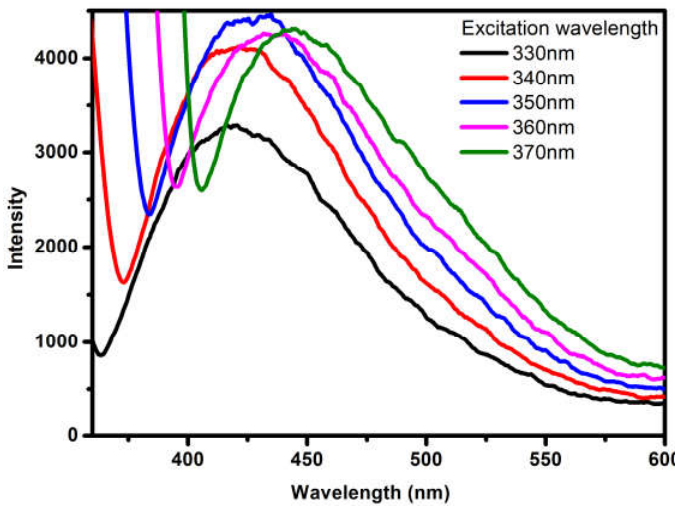
Figure 9. Emission spectra of PANI-Ag composite at different excitation wavelengths.